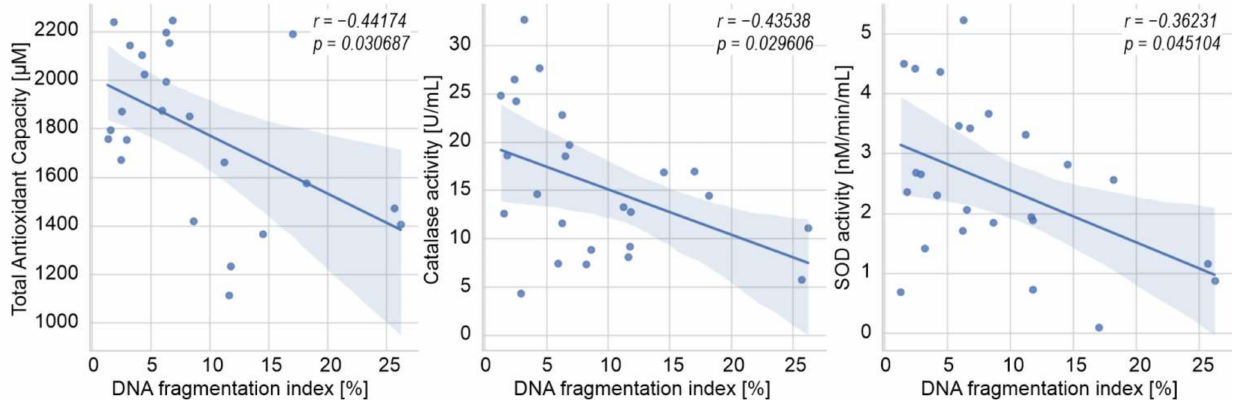
Figure 3. Spearman rank-order correlations between oxidative stress and sperm DNA integrity parameters in the group of infertile men not exposed to genital heat stress. p—p value, r— Spearman’s correlation coefficient, SOD—superoxide